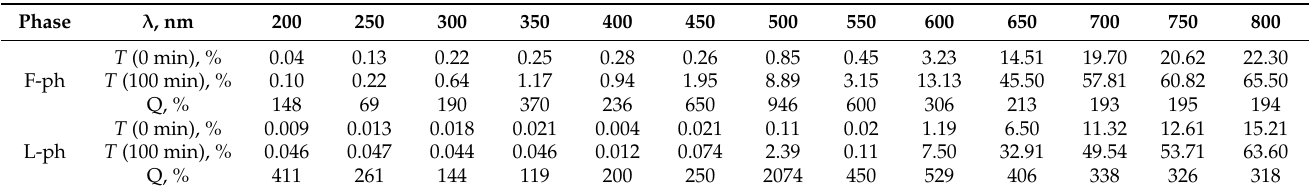
Table 2. Efficiency (Q, %) of optical clearing of the ovarian tissue in different phases of the cycle.